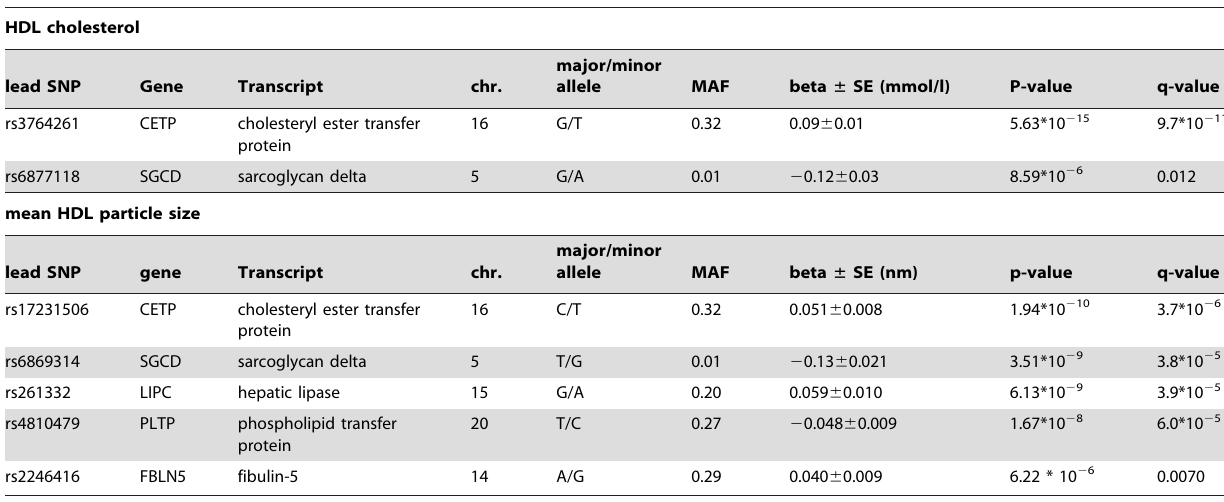
Table 2. Significant association results for HDL cholesterol and HDL particle